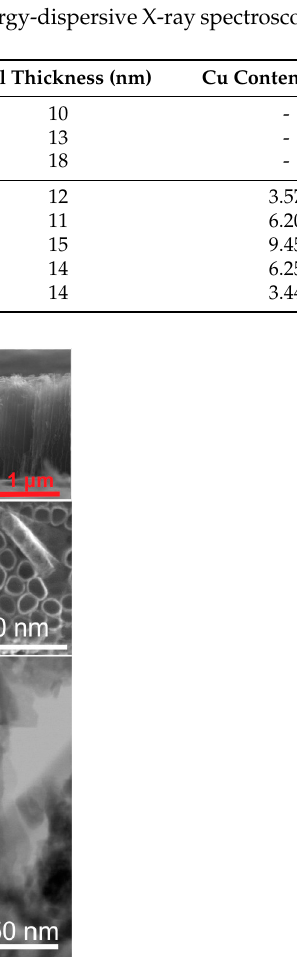
Figure 1. Top-view and cross-sectional SEM images of Ti 95 Cu 5 _30V ( a ), Ti 90 Cu 10 _30V ( b ), Ti 85 Cu 15 _30V ( c ), Ti 90 Cu 10 _40V ( d ), Ti 90 Cu 10 _50V ( e ) samples, and TEM image of Ti 95 Cu 5 _30V ( f ).